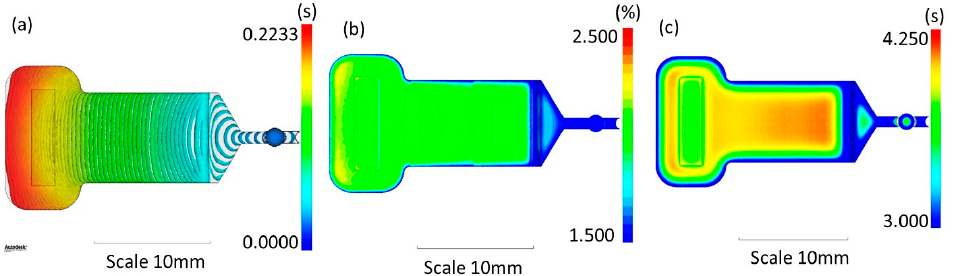
Figure 2. Numerical simulation of 3D filling and packing of the molten polymer in the mold during the μ IM process. ( a ) Polymer filling distribution (time contour plot) (s); ( b ) Volumetric shrinkage in the range 1.5%–2.5%; ( c ) Time to reach ejection temperature in the range 3–4.25 s.